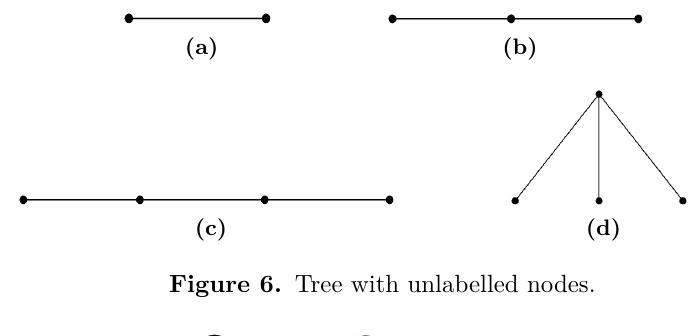
Figure 6. Tree with unlabelled nodes.